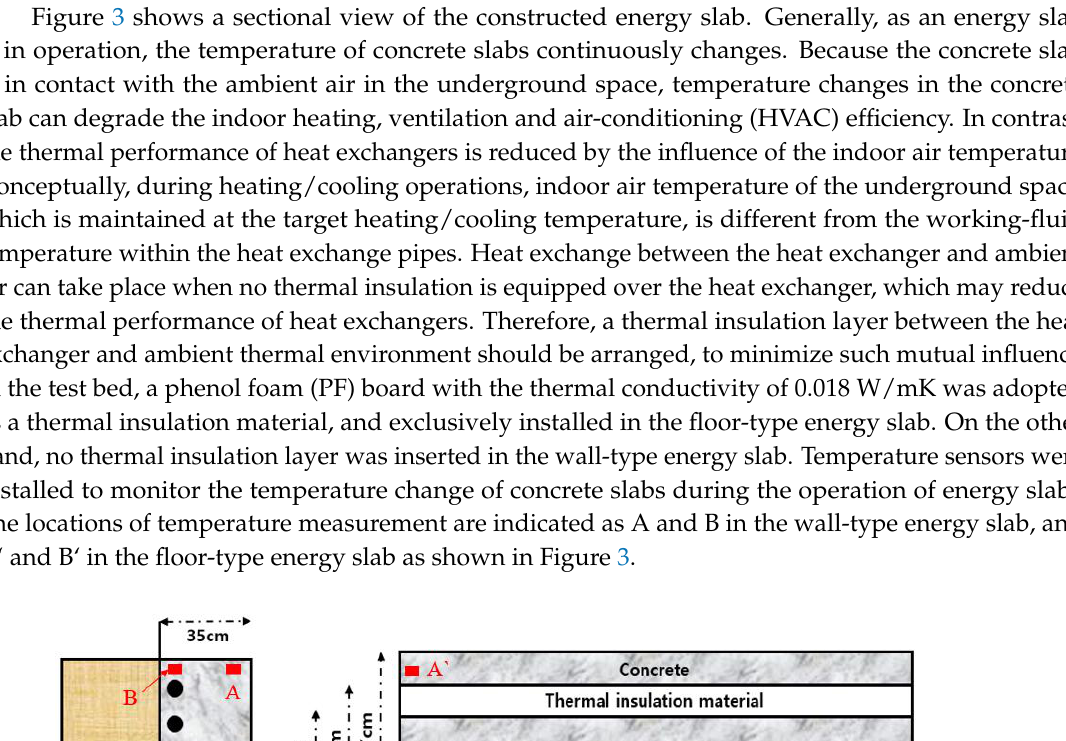
Figure 2. Schematic diagram of constructed energy slab.